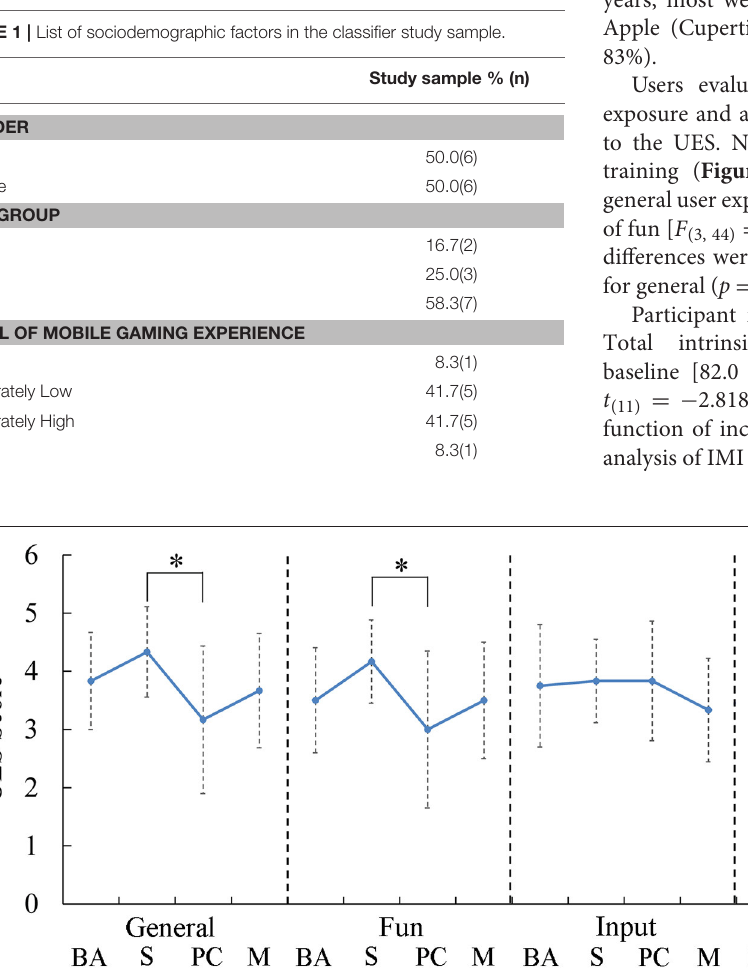
FIGURE 2 | Boxplots of self-reported responses to the user evaluation survey. Participants rated the Dino Sprint (Sequencing) game as significantly higher than Dino Feast (Proportional Control). BA, Basic Activation; S, Sequencing; PC, Proportional Control and Isolation; M, Movement. * p < 0.05.